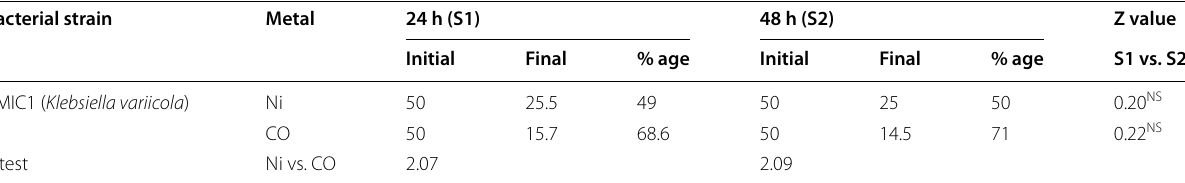
Table 3 Comparison of percentage reduction in Ni and Co by Klebsiella variicola strain AMIC1 determined through ICP- OES Bacterial